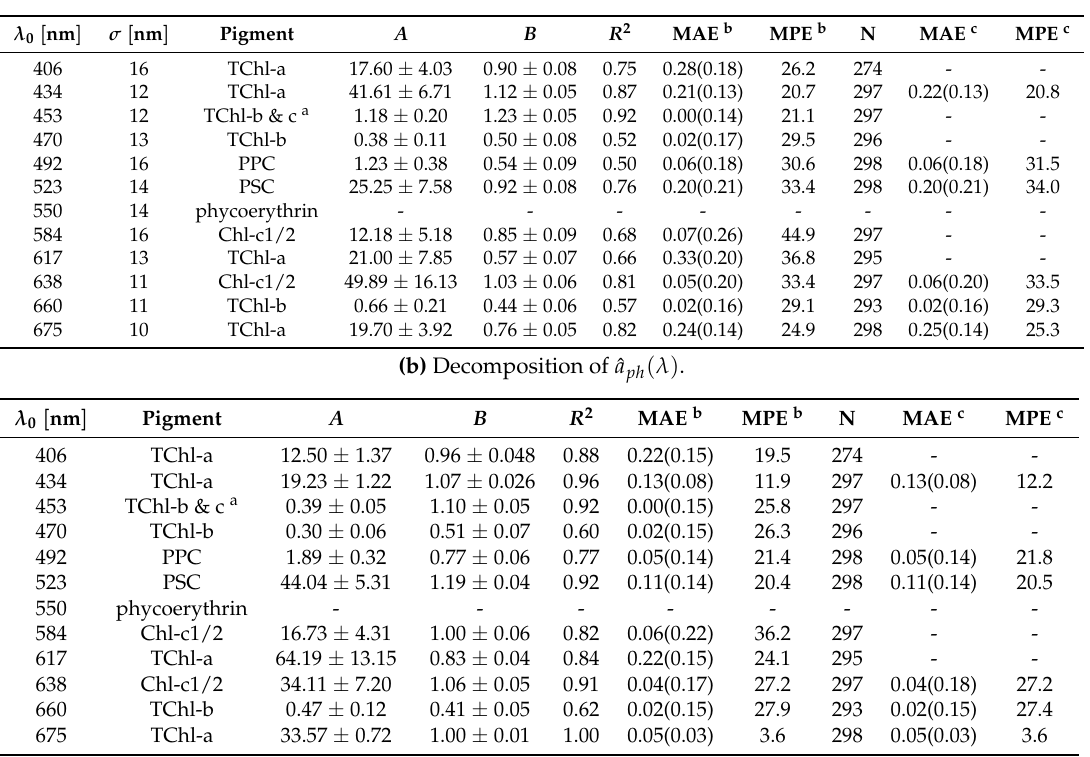
Table 2. The peak wavelengths ( λ 0 ) and widths ( σ ) of the Gaussian functions for phytoplankton pigments, the statistics for the power function regression of a gaus ( λ 0 ) -pigment pairs in the training set (regression coefficients A and B of Equation (3) were calculated with 95% confidence bounds), and the statistics based on leave-one-out cross-validation. MAE is in mg m − 3 (values outside the parentheses were calculated with linear-scale values, while inside the parentheses with log10-scale values), MPE in %, and N is the number of data points for the